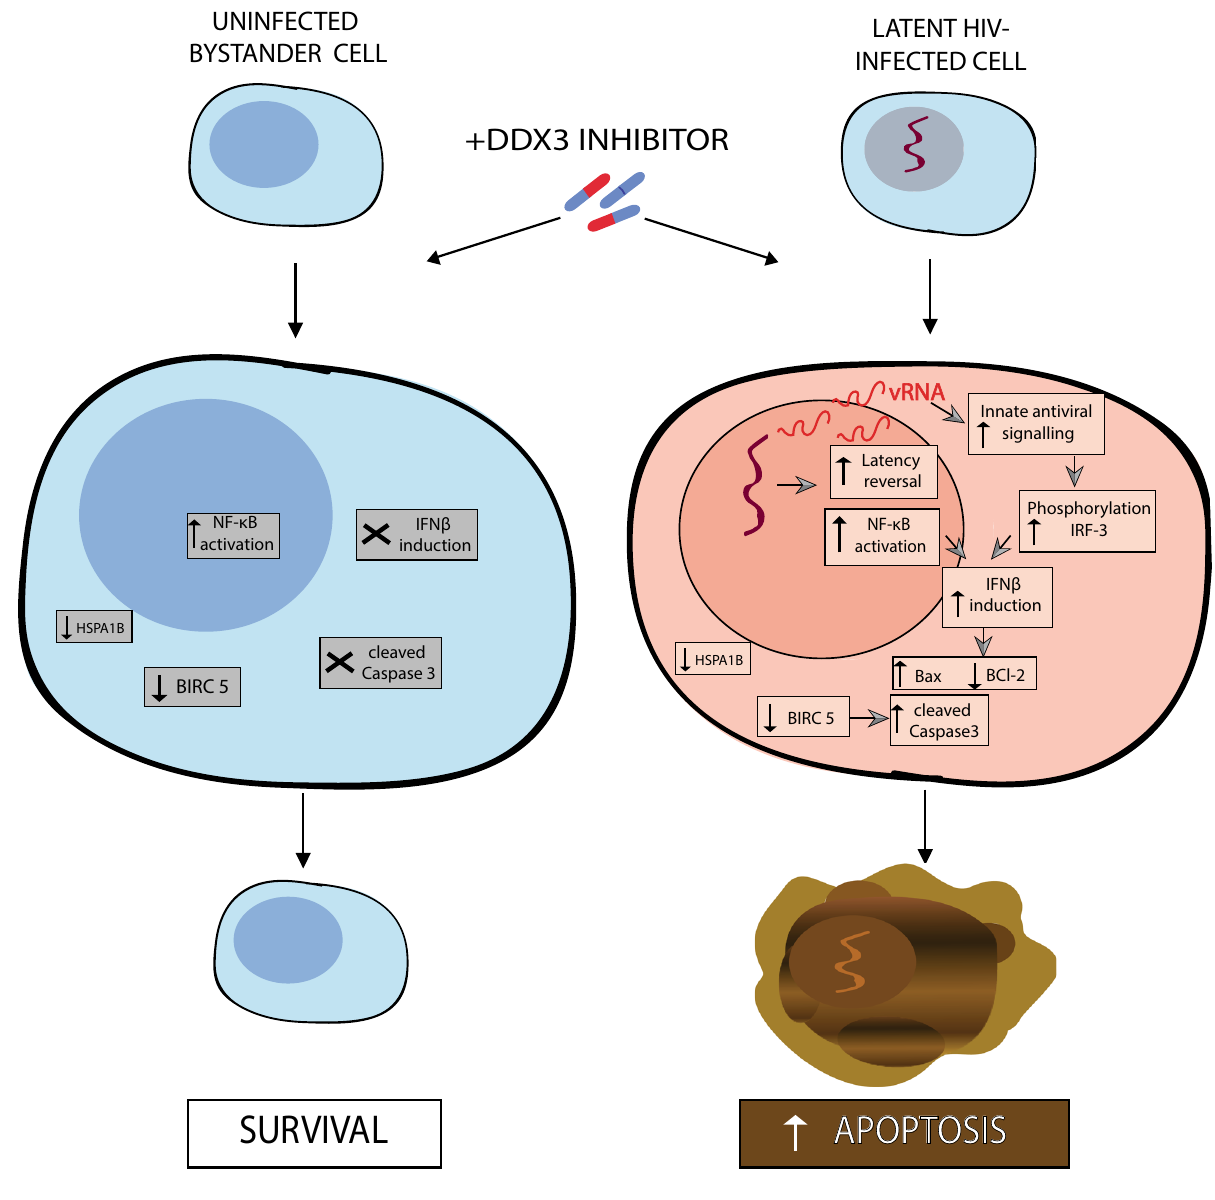
Fig. 7 Model for latency reversal and cell death induced by DDX3 inhibition. DDX3 inhibition results in HIV-1 latency reversal, possibly via NF- κ B activation, and BIRC5 and HSPA1B downregulation in both uninfected bystander and latent proviral-containing cells. The HIV-1 provirus is reactivated generating vRNA that can activate innate antiviral signalling pathways, phosphorylate IRF3 and induce IFN β expression, which when combined with BIRC5 or HSPA1B downregulation, results in upregulated Bax, downregulated BCl2, increased cleaved caspase-3 and apoptosis of the vRNA-expressing cells, but leaving the uninfected cells unharmed, thereby resulting in a reduction in the viral